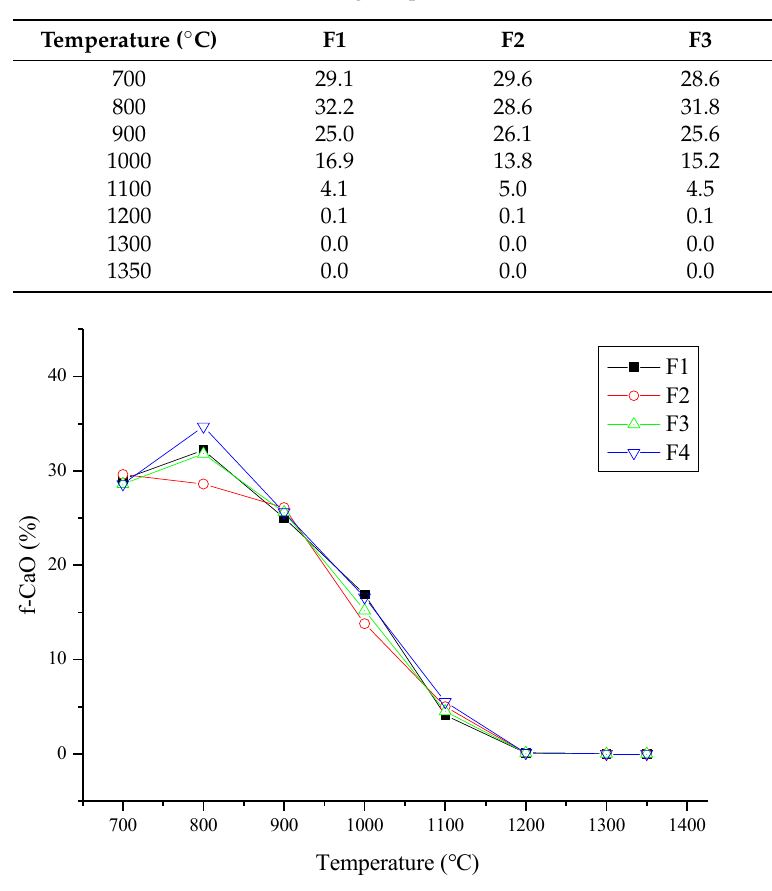
Figure 3. Mass fraction of f-CaO in samples vs. temperature.